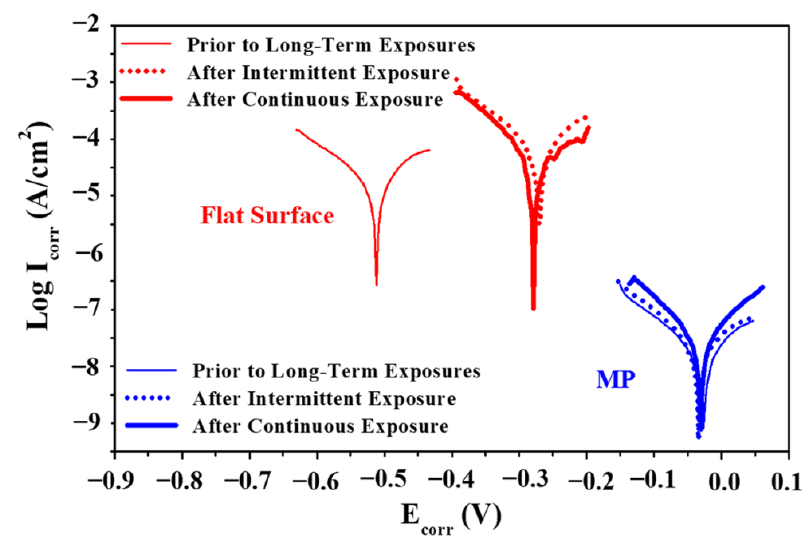
Table 3. Corrosion parameters (E corr , i corr , and corrosion rate, CR) of the flat surface and micropillar surface [1] (MP) after long-time contacts with NaCl solution.